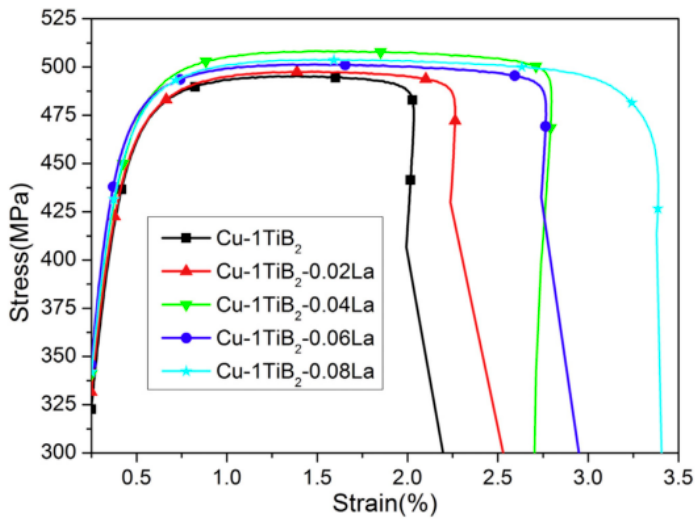
Figure 10. Stress–strain curves of Cu–1 wt.% TiB 2 with different content of La [24]. Reprinted/adapted with permission from Ref. [24]. Copyright year 2016, Elsevier.